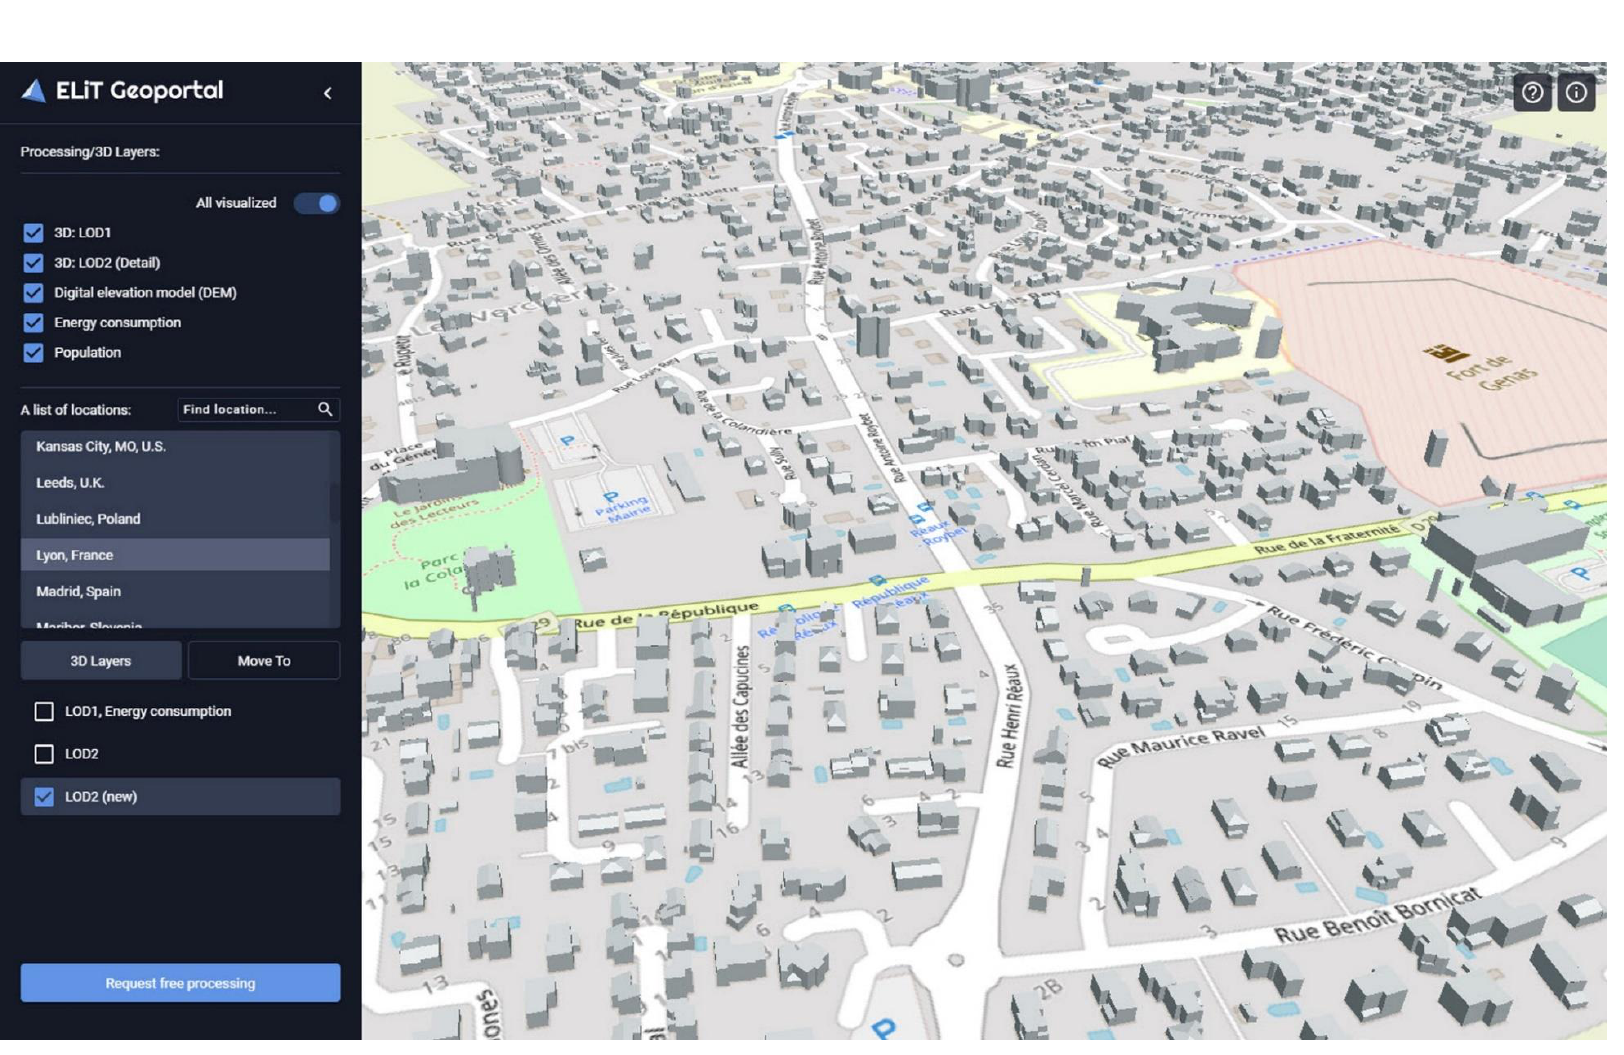
Figure 7. A fragment of a whole urban area of Lyon, France presented on the Geoportal as 3D CityGML LOD2 models. OSM is used as a ground-basis.